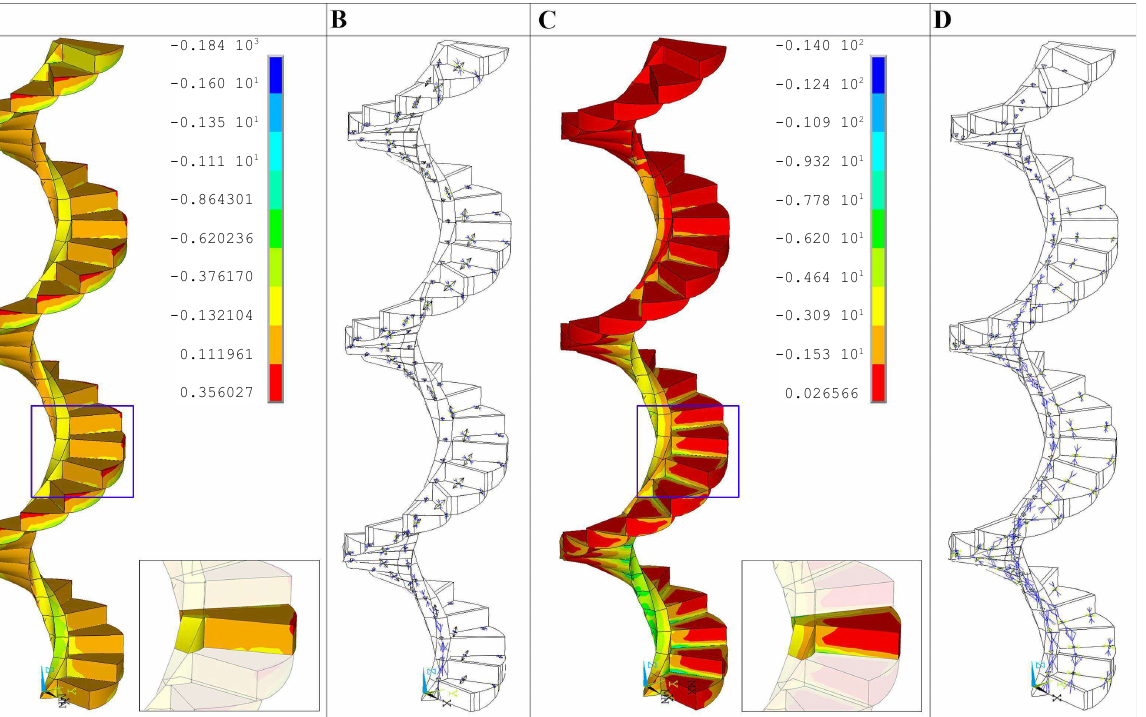
Figure 8. Helicoidal staircase of Nisida: ( A , B ) 3th Principal stress (Unit: MPa) and Vector plot of the thrust in the case of clamped boundary conditions; ( C , D ) 3th Principal stress (Unit: MPa) and Vector plot of the thrust in the case of sliding boundary